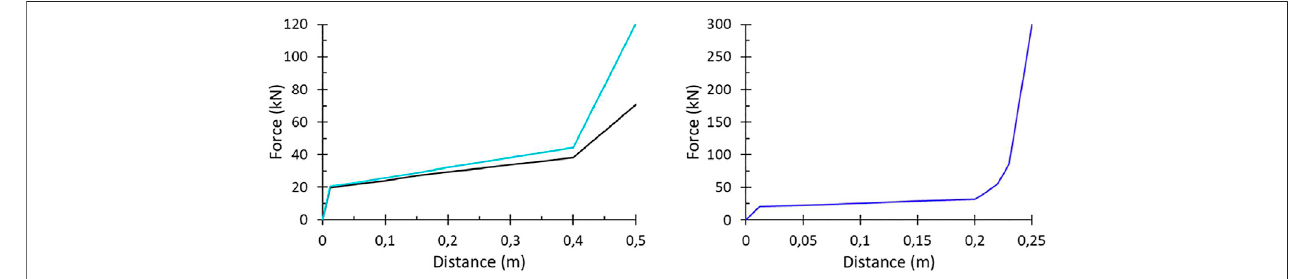
FIGURE 4 | Left: STLL force characteristics vs. displacement for adaptive (black) and passive without soft stop (light blue). Right: STLL force characteristics vs. displacement for passive with a soft stop limit the seat stroke to 0.25 m (dark